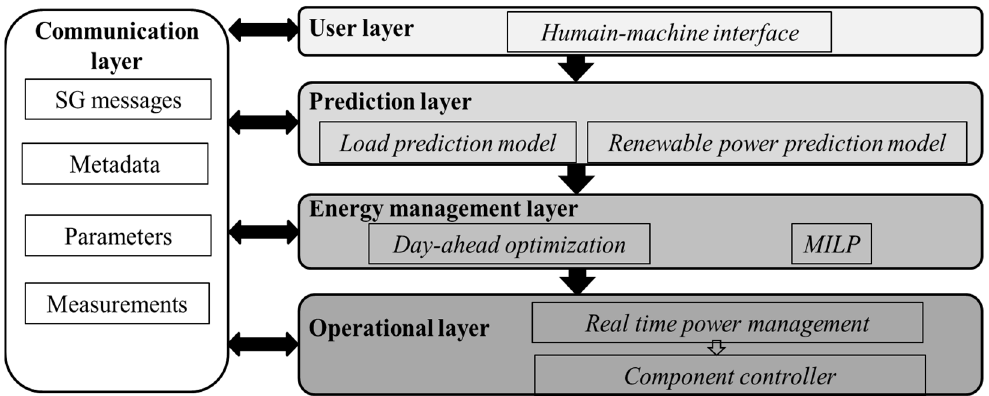
Figure 2. MG multi-layer supervisory concept.